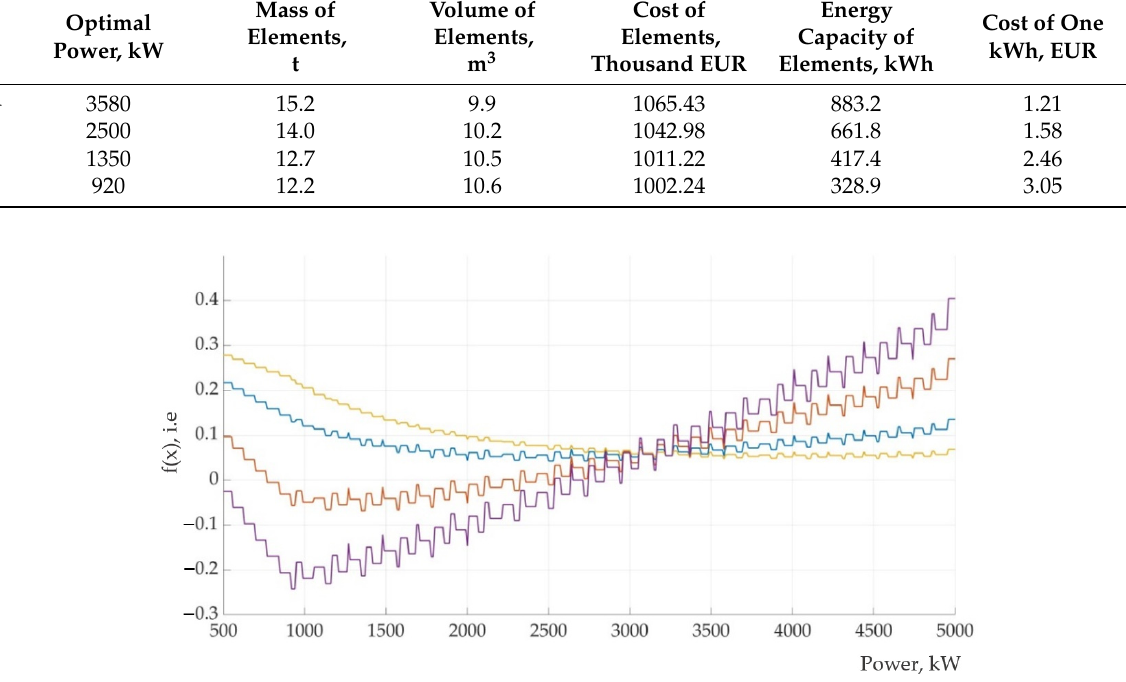
Figure 7. Dependence of the objective function (the yellow line is the objective function with coefficients { 0,05;0,05;0,9 } ; the blue line is the objective function with coefficients { 0,1;0,1;0,8 } ; the red line is the objective function with coefficients { 0,2;0,2;0,6 } ; and the purple line is the objective function with coefficients { 0,3;0,3;0,4 }